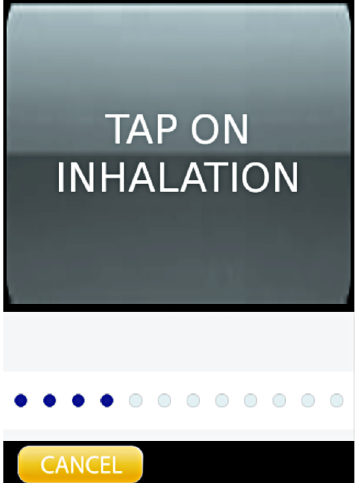
Figure 2. Screenshot of tapping screen of the RRate application. A button records taps and an indicator displays how many taps have been performed (bottom).